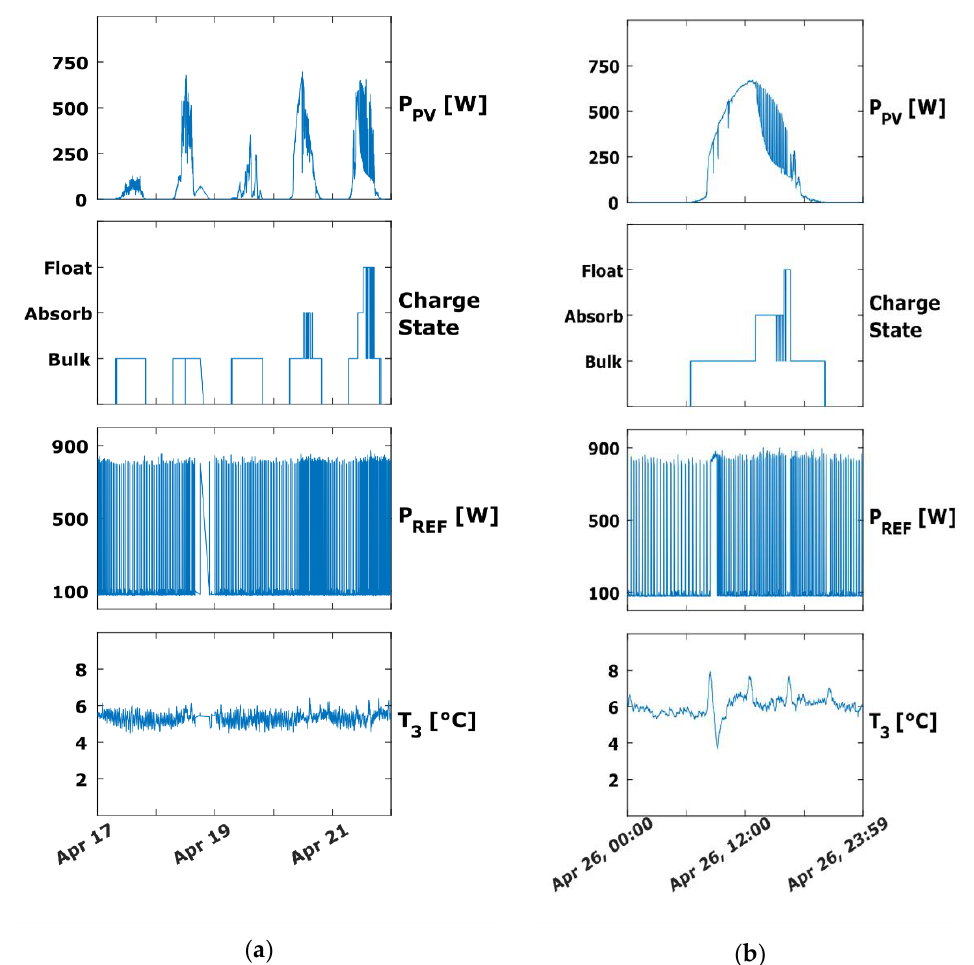
Figure 15. System resilience after three days with low solar radiation between 17 and 21 April 2022 ( a ); test case on 26 April 2022 ( b ).